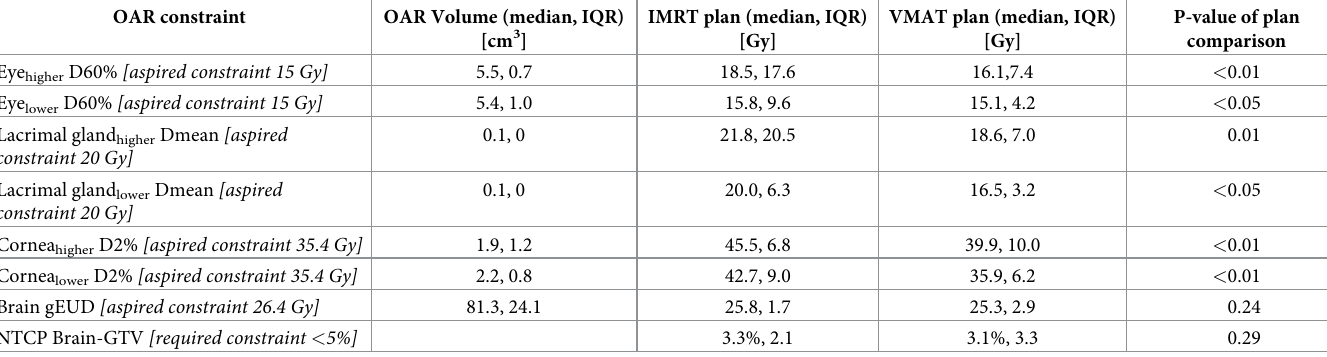
Table 3. Organ at risk volume and actual constraint dose per plan.